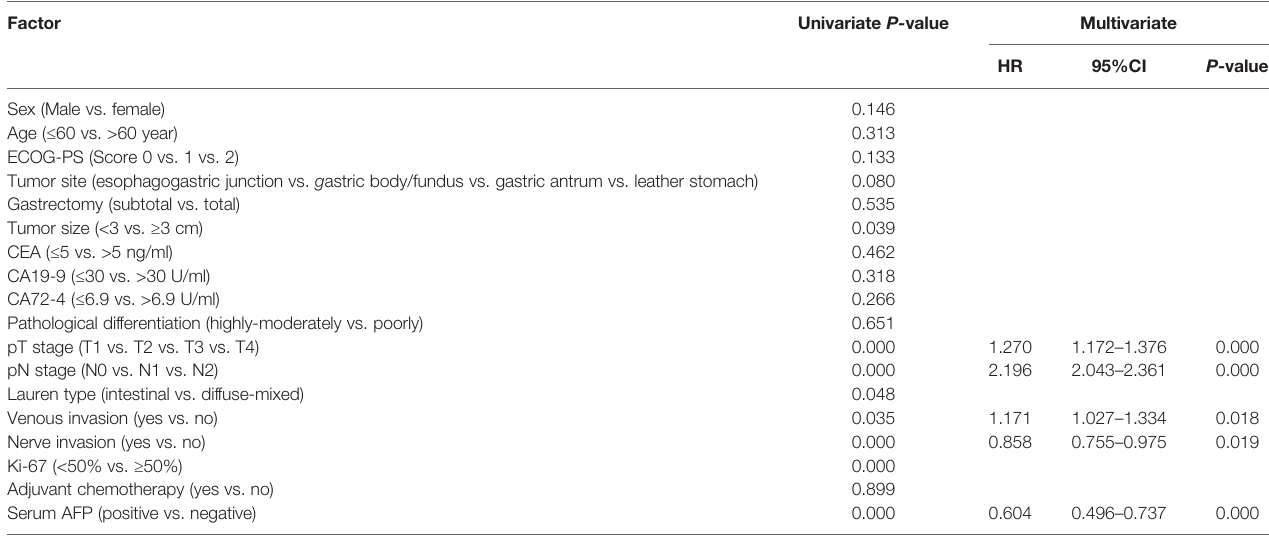
TABLE 2 | Univariate and multivariate survival analyses in 2,318 patients with GC.